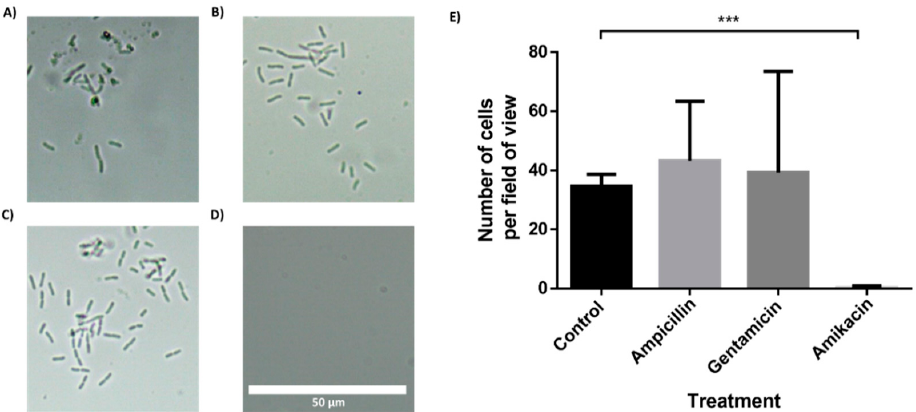
Figure 6. Antibiotic susceptibility testing of Klebsiella pneumoniae, isolated from a clinical urine sample. The multi-channel chip with superhydrophobic and hydrophilic coatings was loaded with a K. pneumonia in LB and incubated for 2 h. ( A ) Control channel. Channel with drop-dried ( B ) ampicillin, ( C ) gentamicin and ( D ) amikacin. ( E ) Manual cell count per field of view (235 µm × 100 µm) using a 60× magnification and a brightfield microscope. n = 3. Error bars indicate standard deviation (SD). *** P ≤ 0.001.